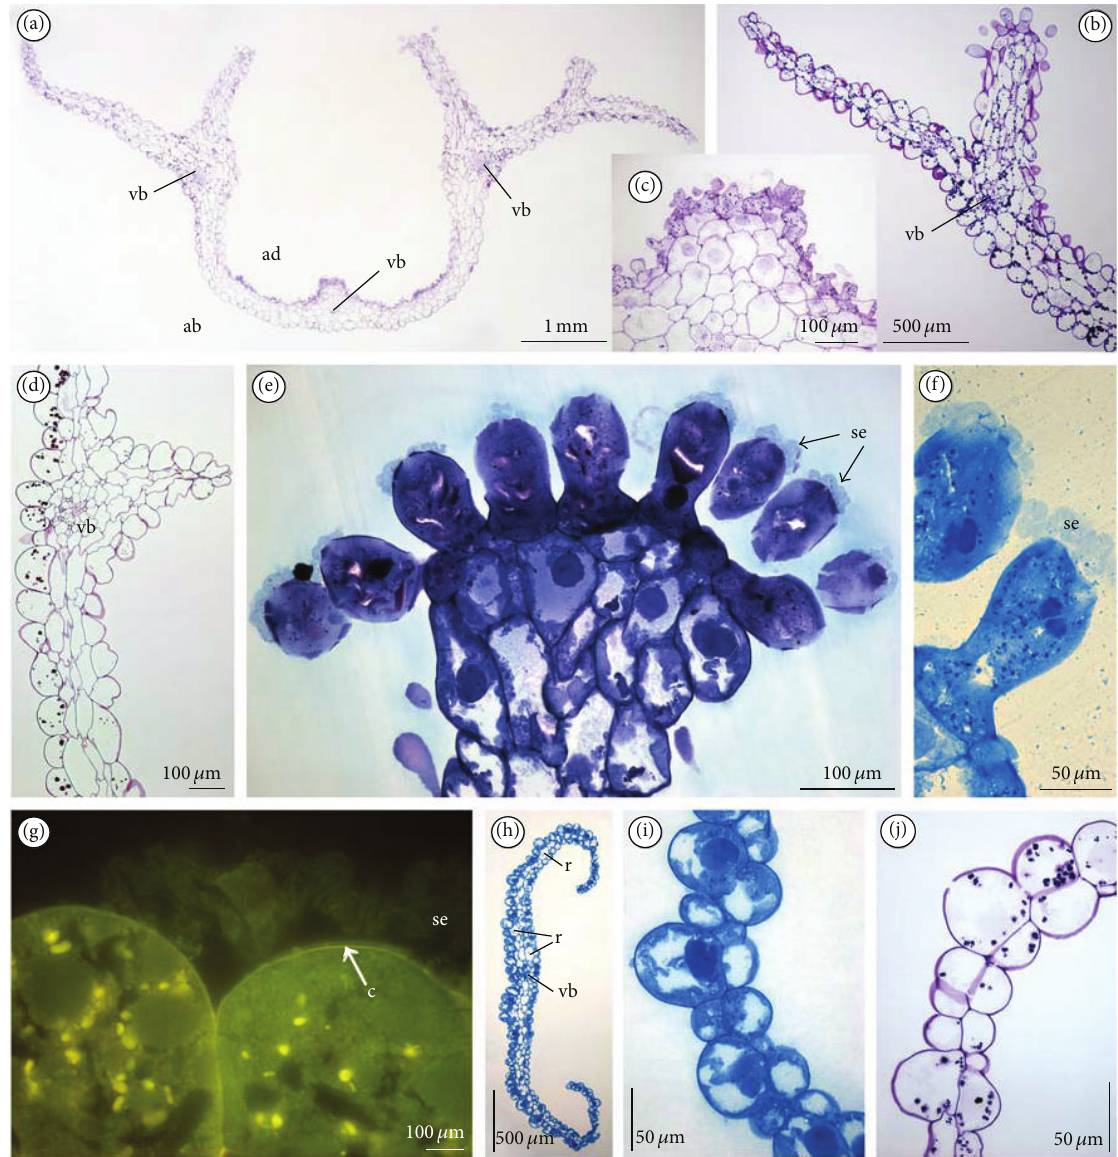
Figure 3: LM observations of tepals. (a) Cross-section of lip with collateral vascular bundles in parenchyma (PAS). (b) Lip part with starch grains in cells on the 3rd day of anthesis stained for polysaccharides insoluble in water (PAS). (c) Central part of furrow from the lip with sunken cells on the top, 3rd day, stained for polysaccharides (PAS). (d) Lip part with starch grains only in abaxial epidermis, 6th day (PAS). (e) Papillate ridges, note the secretion at the top and dense cytoplasm in papillae, the 4th day of anthesis (TBO). (f) Secretion on papillae, 4th day, stained for proteins (ABB). (g) Thin layer of cuticle, 6th day (Auramina O). (h) Cross-section of dorsal sepal with idioblasts with raphides (TBO). (i) Dorsal sepal stained for proteins (ABB). (j) Dorsal sepal with tiny starch grains (PAS) (ad: adaxial (inner) surface,